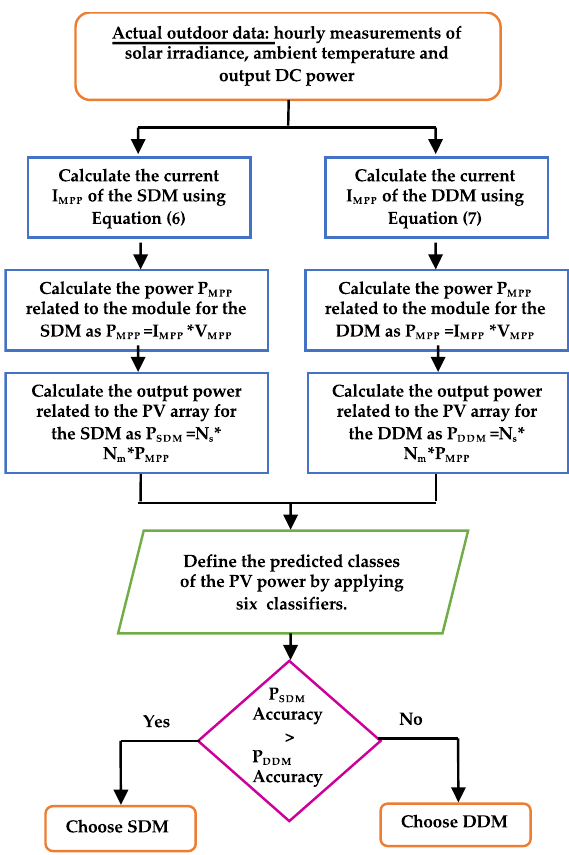
Figure 8. Adopted strategy to classify the adequate equivalent-circuit model according to climatic variations. DC: direct current, SDM: single-diode model, DDM: double-diode model; MPP: Maximum power point.